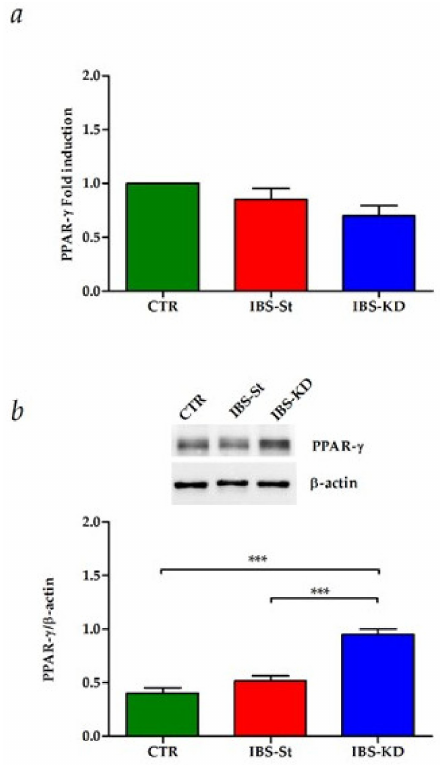
Figure 3. ( a ) Peroxisome proliferator-activated receptor-gamma (PPAR- γ ) gene expression levels in the control group (CTR), IBS rats fed a standard diet (IBS-St), and IBS rats treated with low- carbohydrate, high-fat ketogenic diet (IBS-KD). ( b ) PPAR- γ protein expression levels, and representa- tive blots in the control group (CTR), IBS rats fed a standard diet (IBS-St), and IBS rats treated with low-carbohydrate, high-fat ketogenic diet (IBS-KD). All data represent the results of three different experiments (mean ± SD); p -value was determined by ANOVA with Tukey’s multiple comparison test; *** p <